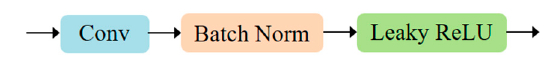
Figure 4. Composition of the CBL block .